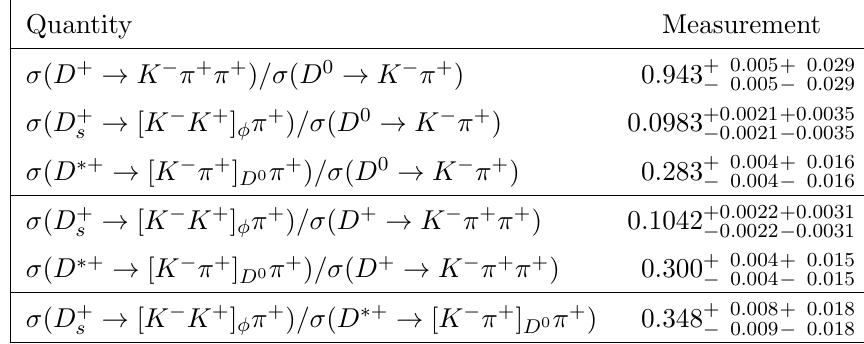
Table 5. Ratios of the measurements of cross-section times branching fraction in the kinematic range 1 < p T < 8 GeV = c and 2 < y < 4 : 5. The (cid:12)rst uncertainty on the ratio is statistical and the second is systematic. The notation (cid:27) ( D